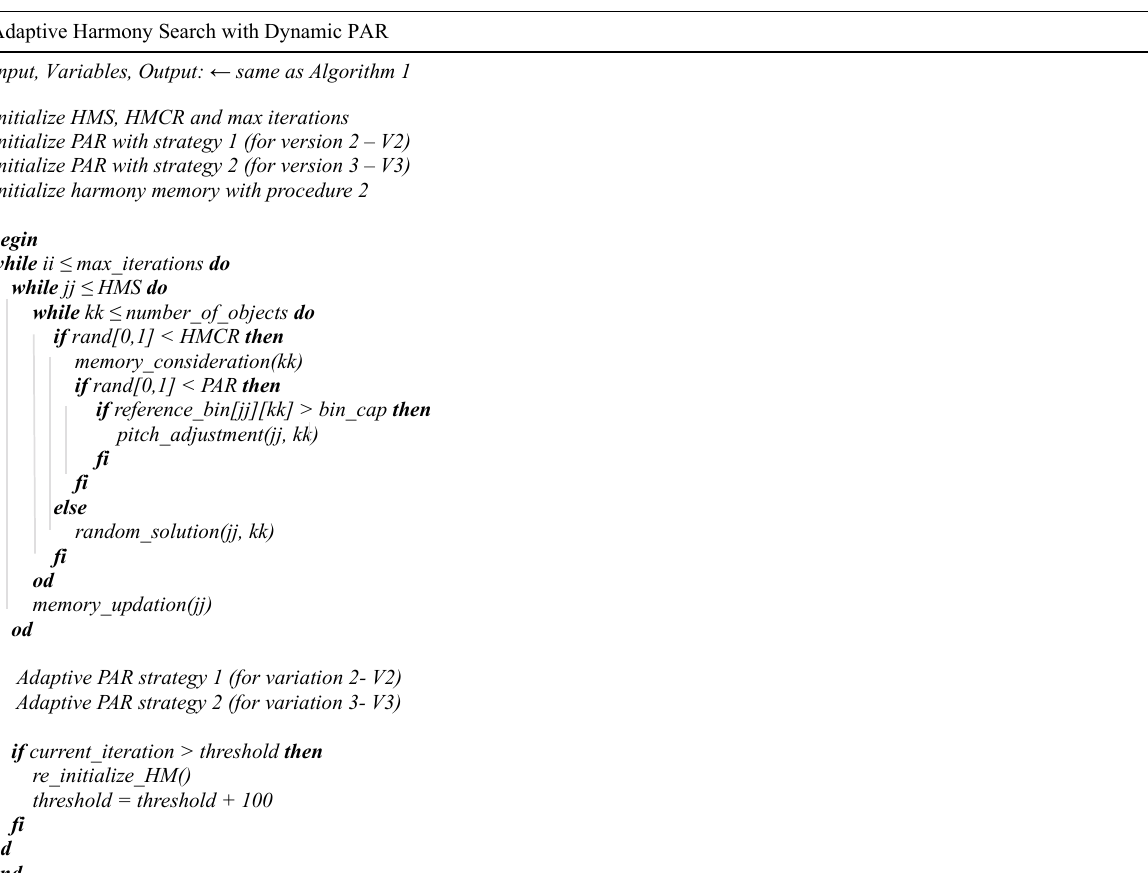
Fig. 7. Pseudocode Adaptive Harmony Search with dynamic PAR (V2 and